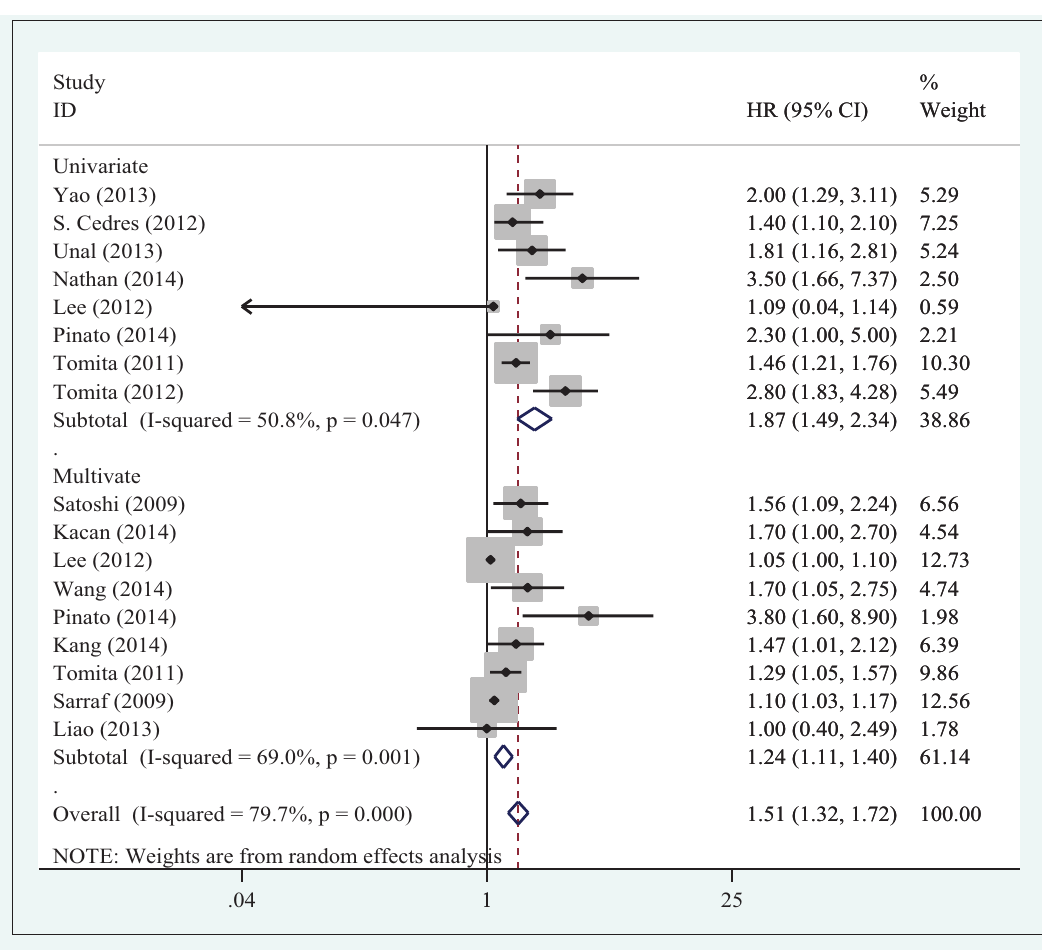
Figure 2 - Forrest plots of studies evaluating HRs of the NLR for